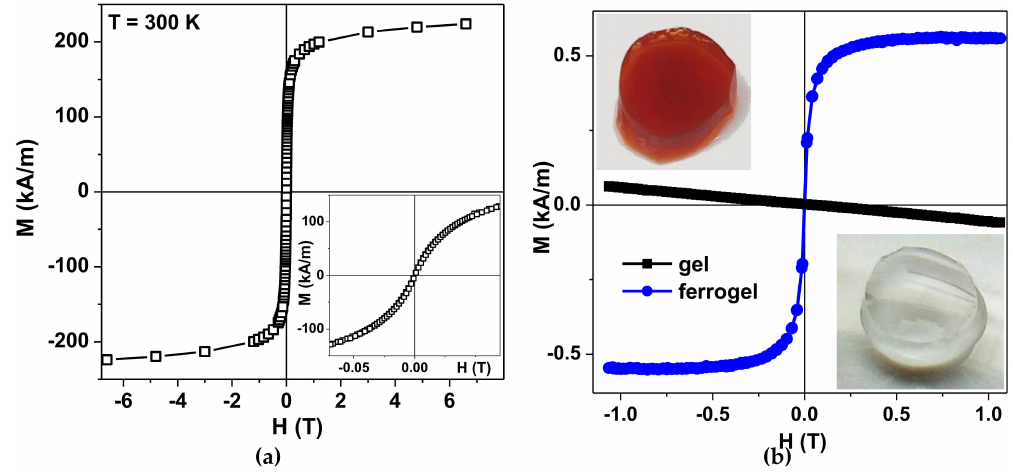
Figure 4. ( a ) Magnetic hysteresis loop of air-dried maghemite LTE MNPs. Inset—enlarged view for the low-field range behavior. ( b ) Magnetic hysteresis loop of gel (transparent) and ferrogel filled with maghemite LTE MNPs (opaque). MDAA/AAm ratio was 1:100, MNPs concentration in ferrogel was 0.34